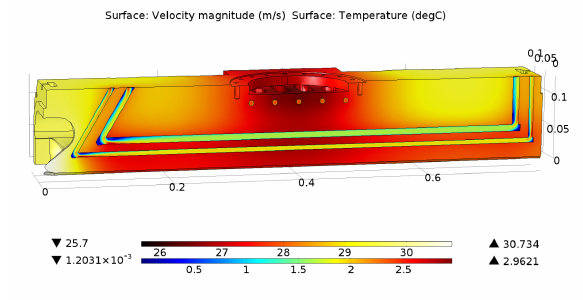
Figure 16. Temperature distribution in the solid and water veloc- ity in the cooling channels, obtained from the thermo-mechanical model of the first segment. Input power corresponds to a duty cy- cle of 5%. Water enters all the channels at 25 ◦ C.